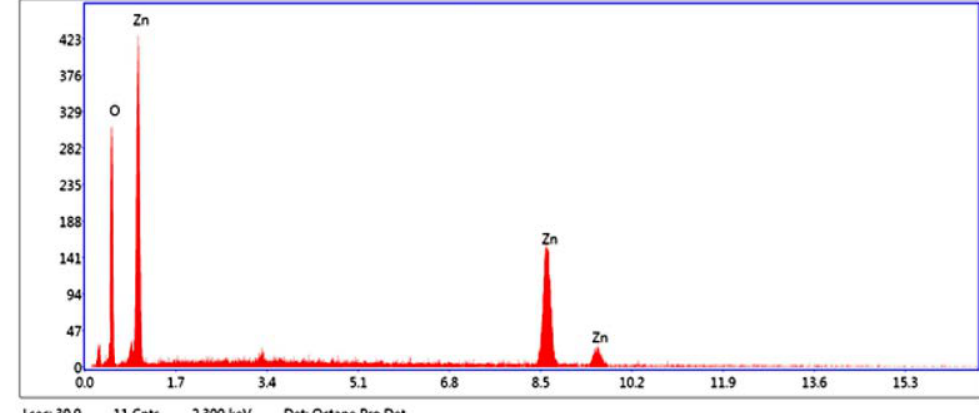
Figure 4. EDX spectrum of ZnO nanoparticles.